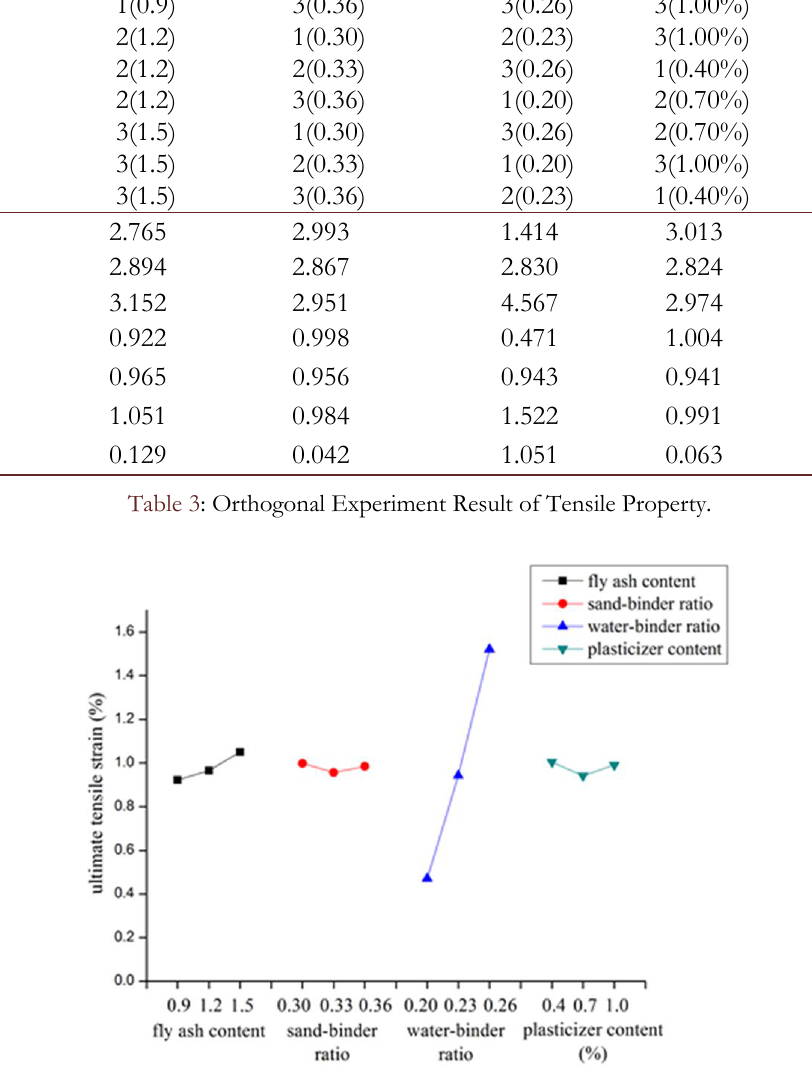
Figure 6: Influence of Changes in Factors on ultimate tensile